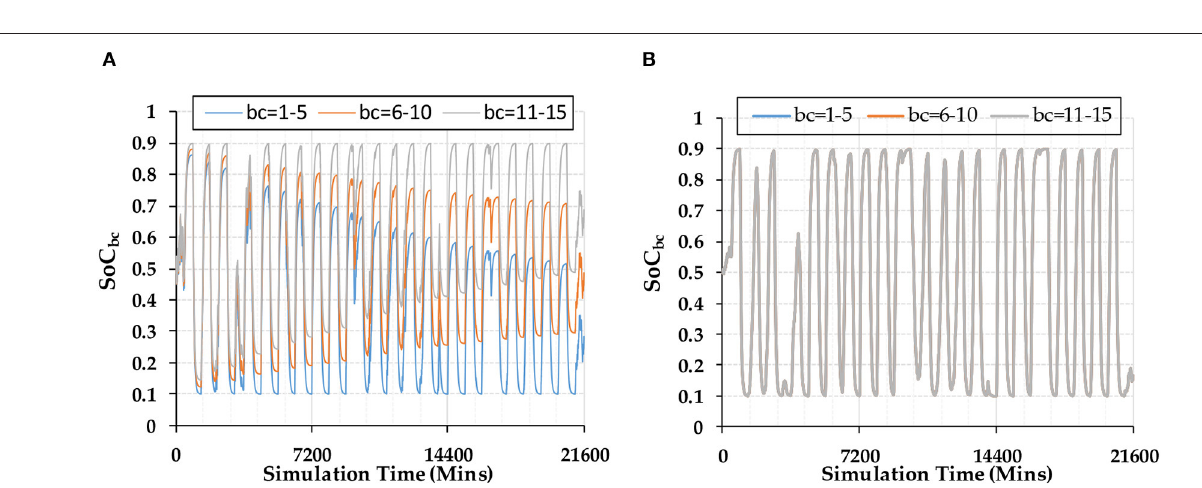
Frontiers in Energy Research |